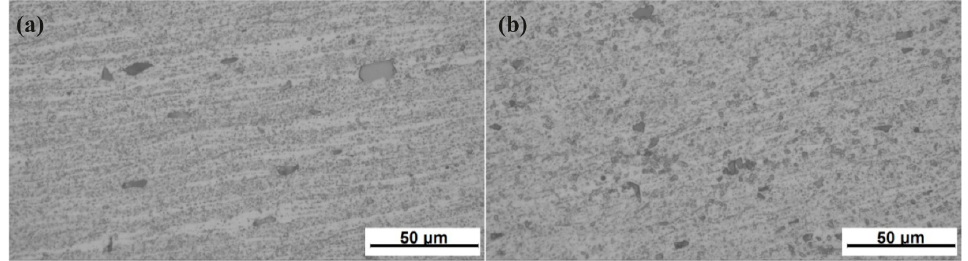
Figure 8. The OM photographs of Al–4.30Mg alloy deformed at 450 °C and a strain rate of 0.01 s − 1 with a reduction of ( a ) 60% and ( b )